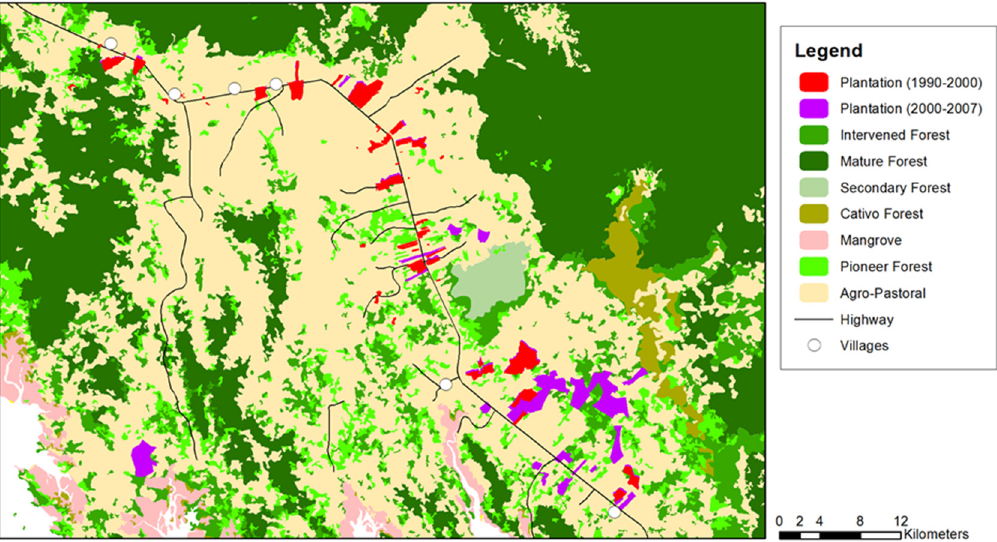
Figure 6. Land Cover in the Bayano ‐ Darién Region, 2007.